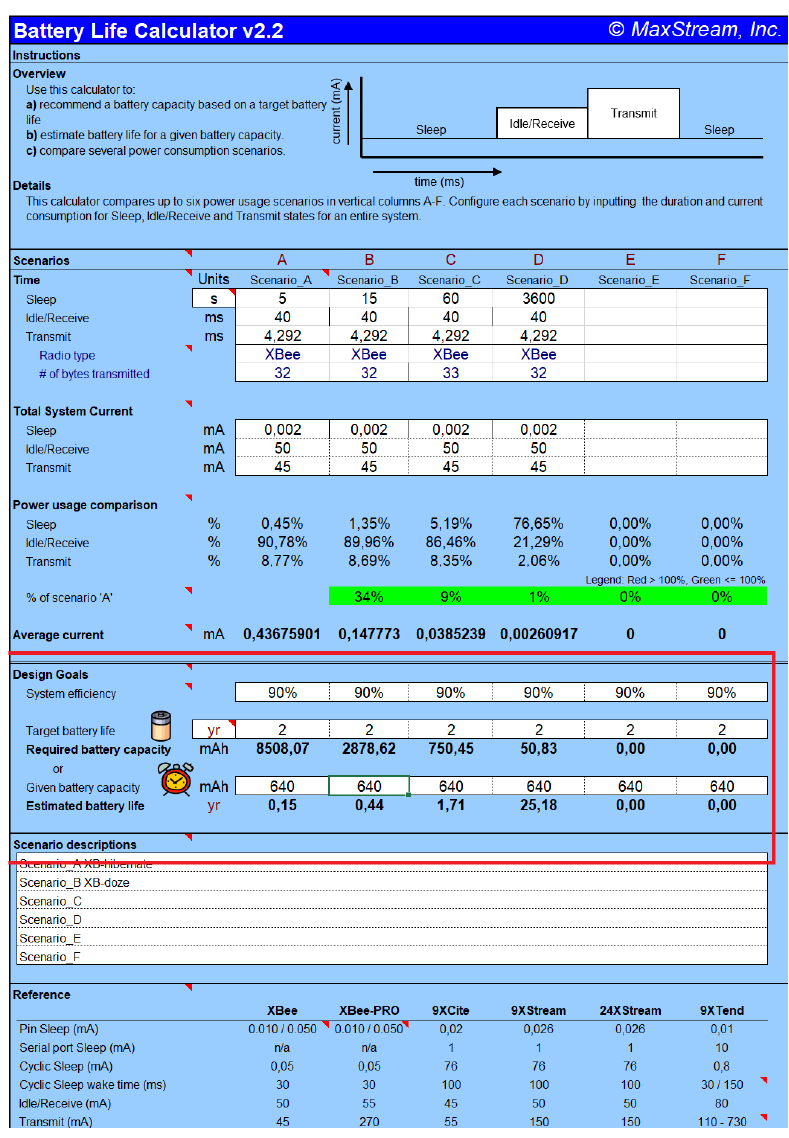
Figure 6. Battery consumption